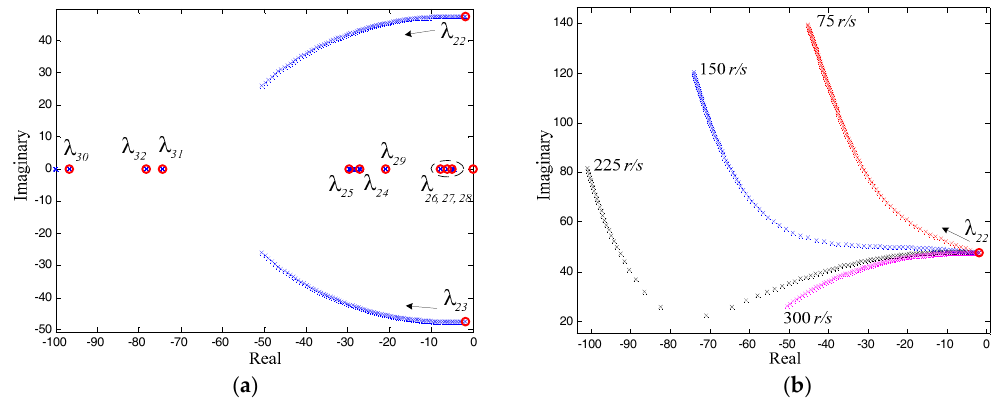
Figure 7. The effect of the proposed supplementary droop loop on the MTDC system stability—the proposed droop loop gain in both VSRs increases from zero to 10 (direction of arrow). ( a ) Cut-off frequency of the HPF = 300 rad/s; ( b ) Different cut-off frequencies of the HPF.